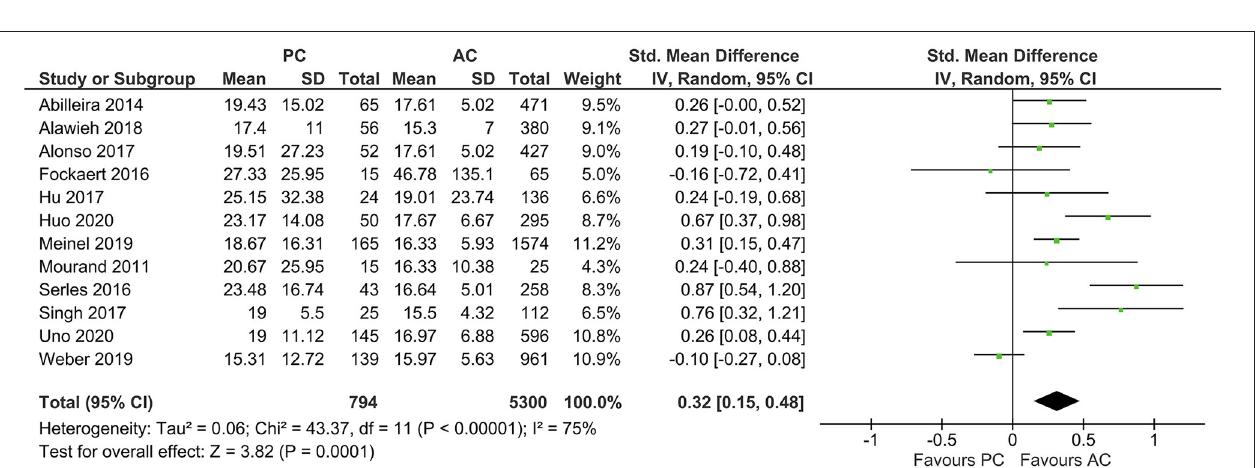
( Figure 7 ). Results from onset-to-recanalization time in PCLVO, however, did not show any difference compared to ACLVO